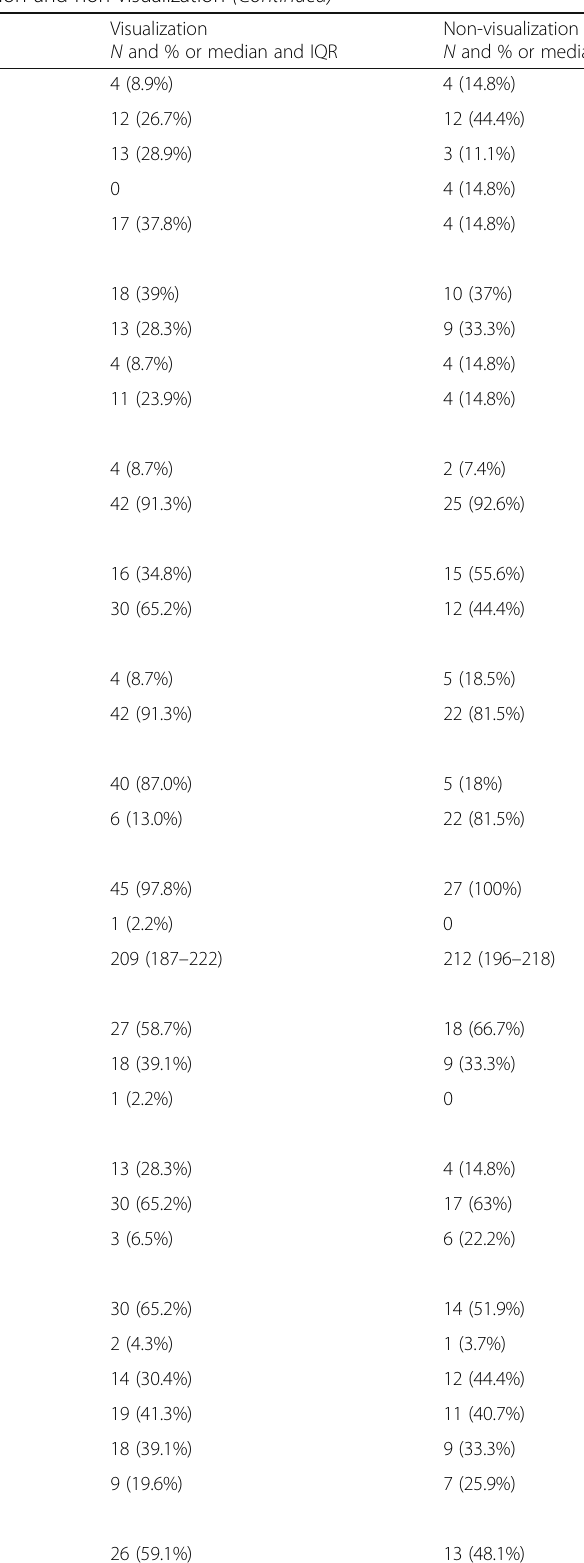
Table 2 Patient and procedure characteristics for visualization and non-visualization (Continued)